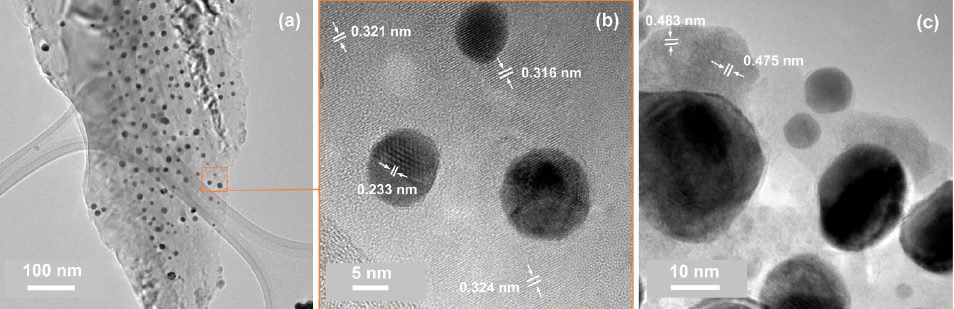
Figure 7. TEM characterization of samples from the C and D series: ( a ) a TEM image of sample D2* at a lower magnification; ( b ) a high-resolution TEM image of a selected area of ( a ); ( c ) a high-resolution TEM image illustrating Au grains and SnO nanocrystals (upper-left